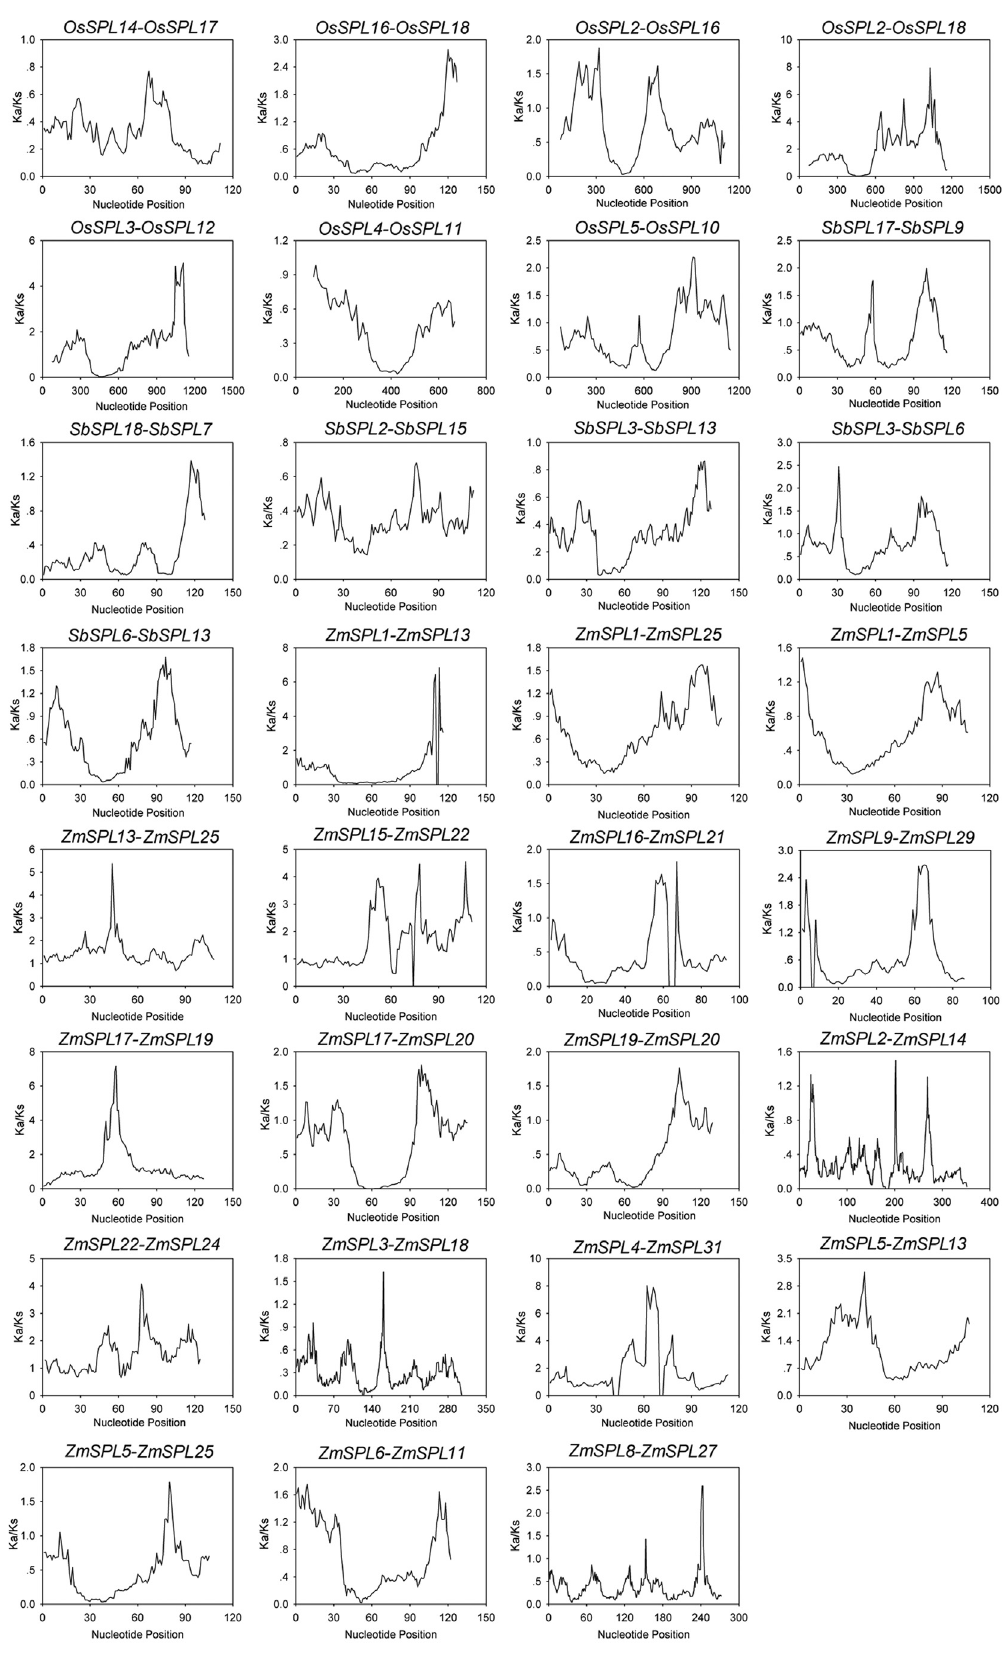
Figure 4 - Sliding window plots of segmental duplicated SPLs. Window size is 150 bp, and step size is 9